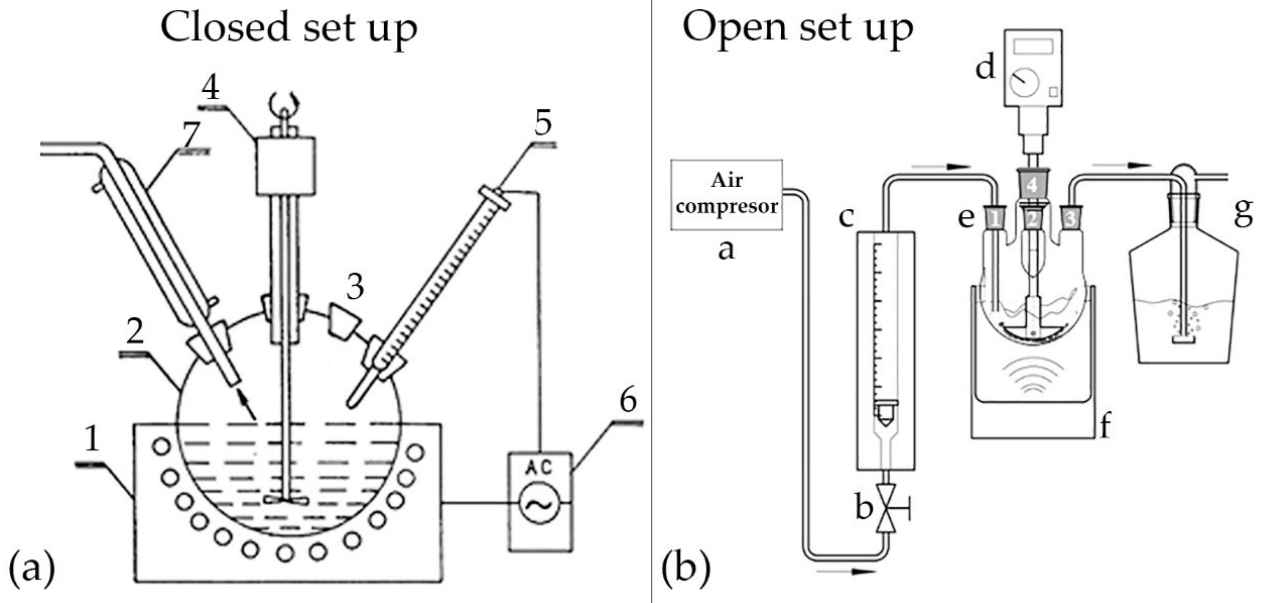
Figure 2. Experimental set-up: ( a ) closed set-up—1 (thermal bath), 2 (reactor), 3 (sampling neck), 4 (mechanical stirrer), 5 (thermocouple), 6 (thermoregulation), 7 (Allihn condenser); ( b ) open set-up—a (air compressor), b (air flow valve), c (rotameter), d (mechanical stirrer), e (reactor), f (ultrasonic bath), g (gas washing bottle), 1 (air injecting neck), 2 (sampling neck), 3 (air outlet neck), 4 (stirrer seal neck).